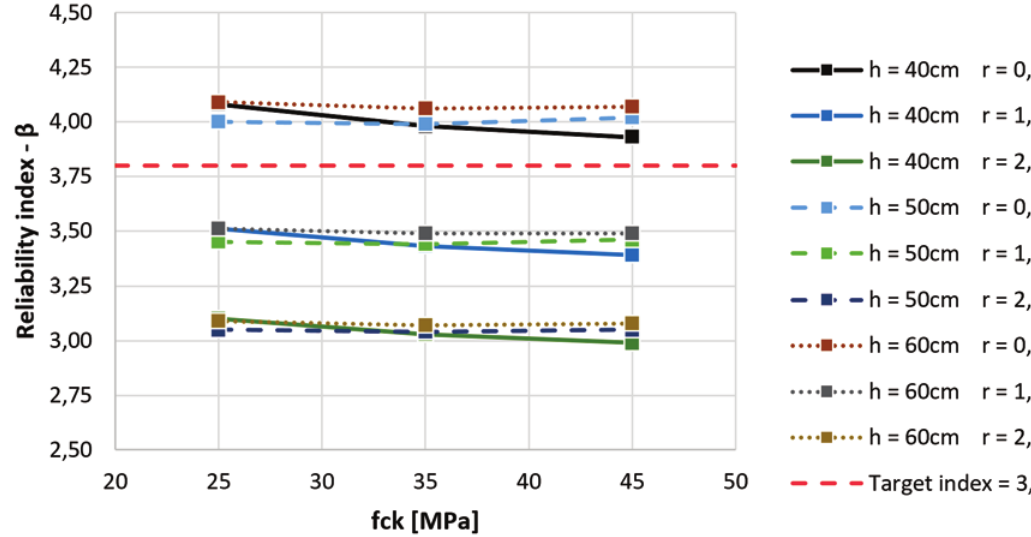
Variation of the reliability index as a function of fck (pk = 15kN/m)